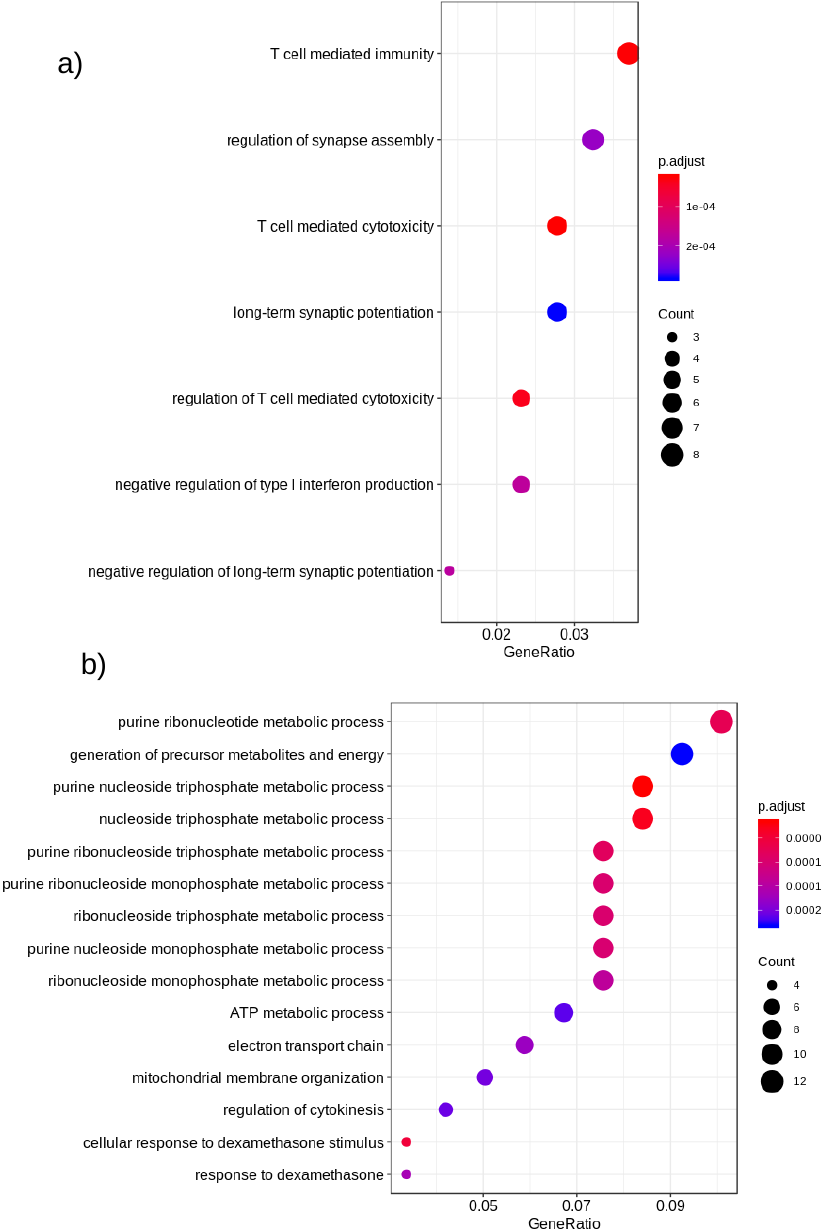
Figure 4. Functional enrichment of differentially-expressed genes of ( a ) AD and ( b ) PD. Here, color denotes the p -value of the association and size represents the number of disease-related genes (DE) associated with the pathway. The x -axis represents the ratio of the number of disease-related genes (DE) to all related genes to the